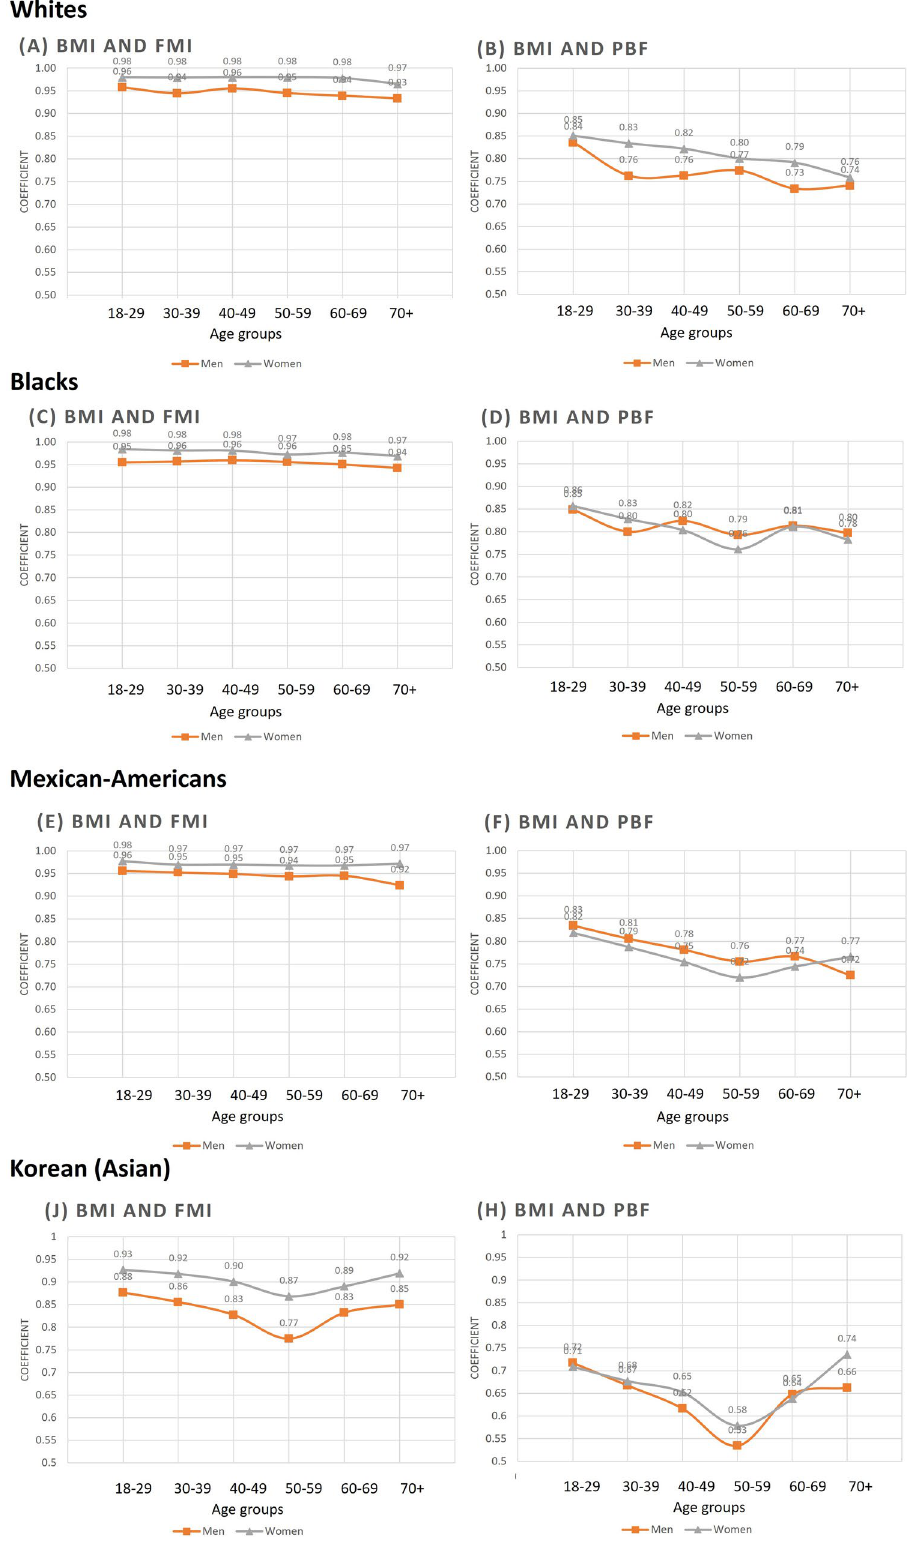
Figure 1. Pearson correlation coefficients between body mass index and DXA derived body adiposity (fat mass index and percentage body fat) by sex and age for each race-ethnicity. The bar graphs of ( A – H ) show coefficients between body mass index (BMI) and fat mass index (FMI) and percentage body fat (PBF) in ( A ) and ( B ) Whites; ( C ) and ( D ) Blacks; ( E ) and ( F ) Mexican-Americans, and ( G ) and ( H )